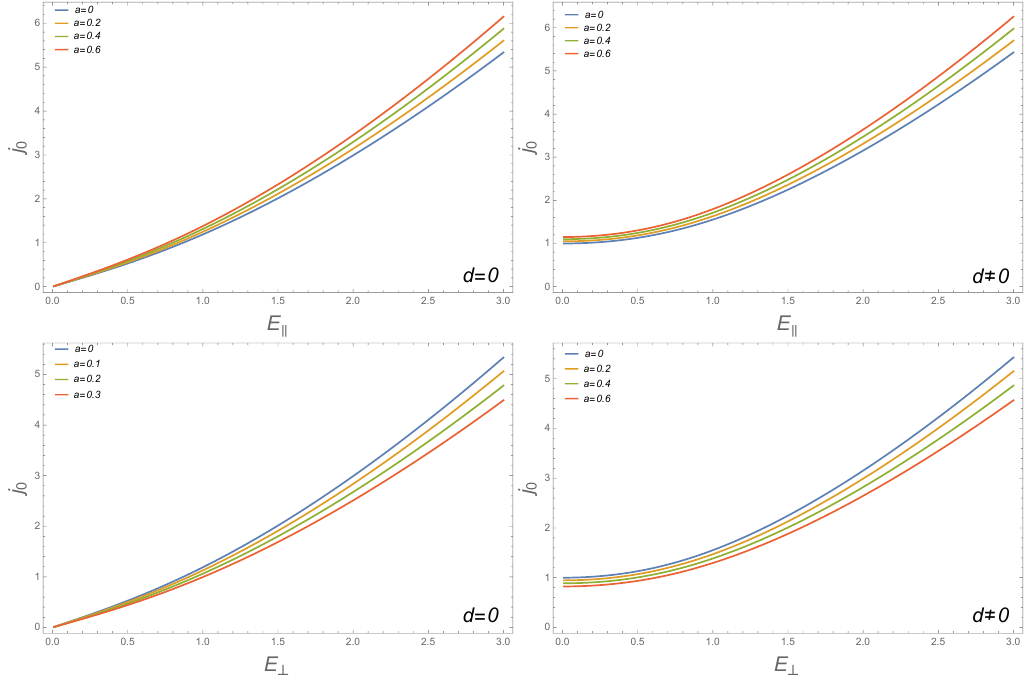
Figure 15 . Relation of j 0 and electric field E